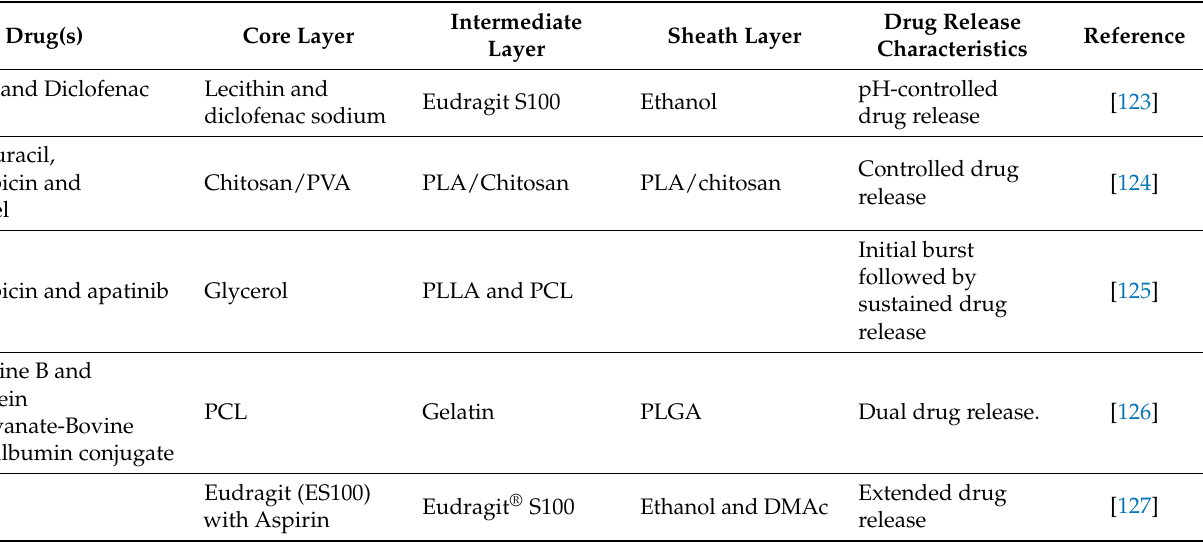
Table 4. Summarised characteristics of some studies employing triaxial electrospinning for drug delivery applications.